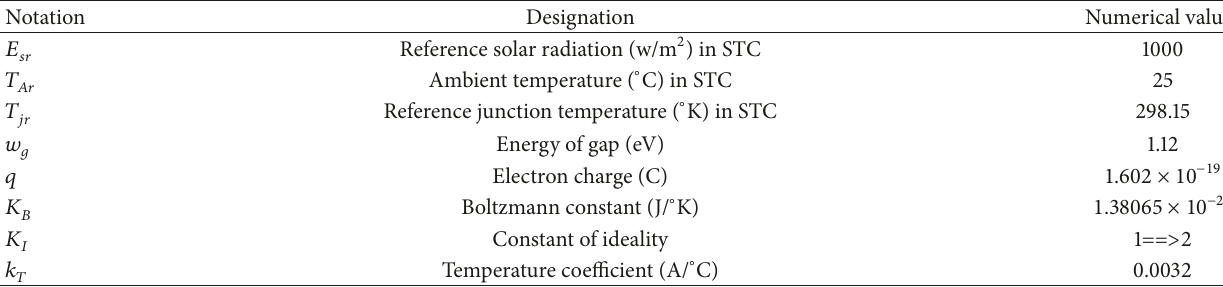
Table 1: Quantities related to the physical model of the solar